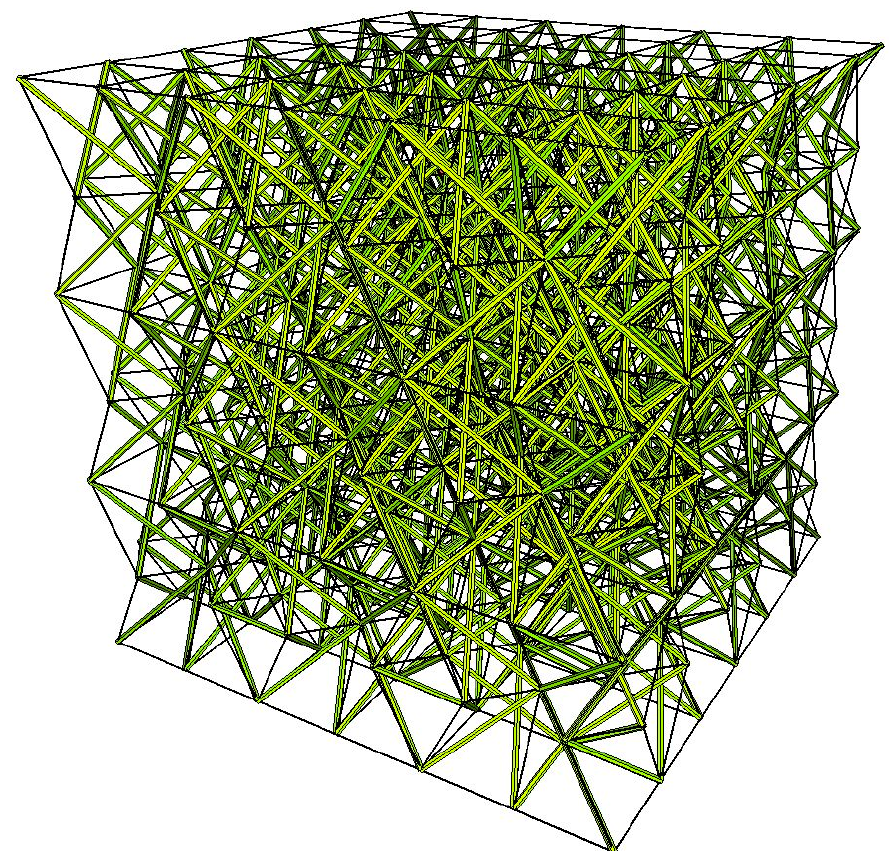
Figure 12. Metamaterial built from the eight-module supercells.